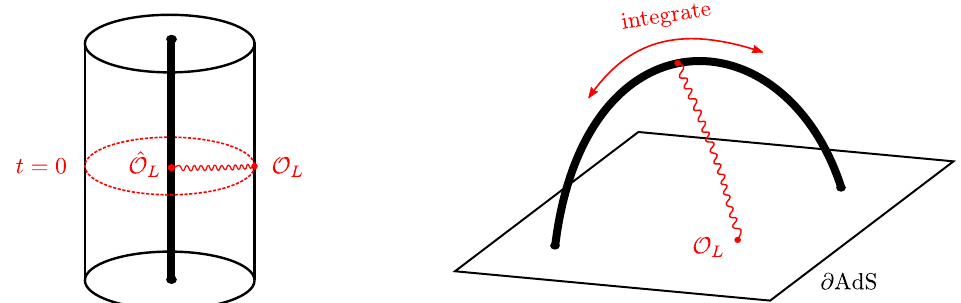
Figure 1: Comparison of our approach and the approach of [ 3, 4 ] . Left: In our approach, we use a radial-quantization picture and compute a matrix element of a light operator O between two D-brane states. This translates to a matrix element L of a dual operator ˆ O defined on the D-brane worldvolume. Right: The approach of L [ 3,4 ] . They considered a trajectory of a D-brane emitted and absorbed from the AdS boundary. They then attached a supergravity mode to the D-brane and integrated over its